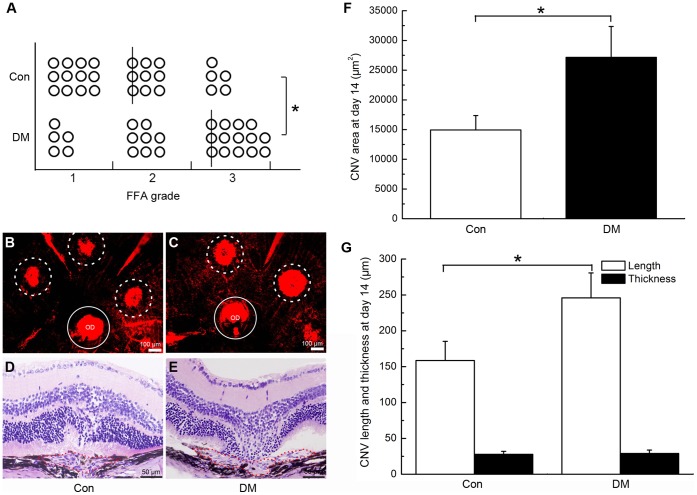
Hyperglycaemia promoted the development of CNV 2 weeks after laser photocoagulation.A, Statistical analysis of the fluorescein leakage in control mice (Con) and diabetic mice (DM) (*P<0.01, lines indicate median leakage levels). B–C, Representative flatmount preparations of the eyecups of control (B) and diabetic (C) mice (Dotted circles: area of CNV; OD: optic disc; Circles: area of OD). D–E, H&E staining images of serial cross-sections of the eye cups of control (D) and diabetic (E) mice. F, Statistical analysis of the data in B and C (*P<0.01); G, Statistical analysis of the data in D and E (*P<0.01).